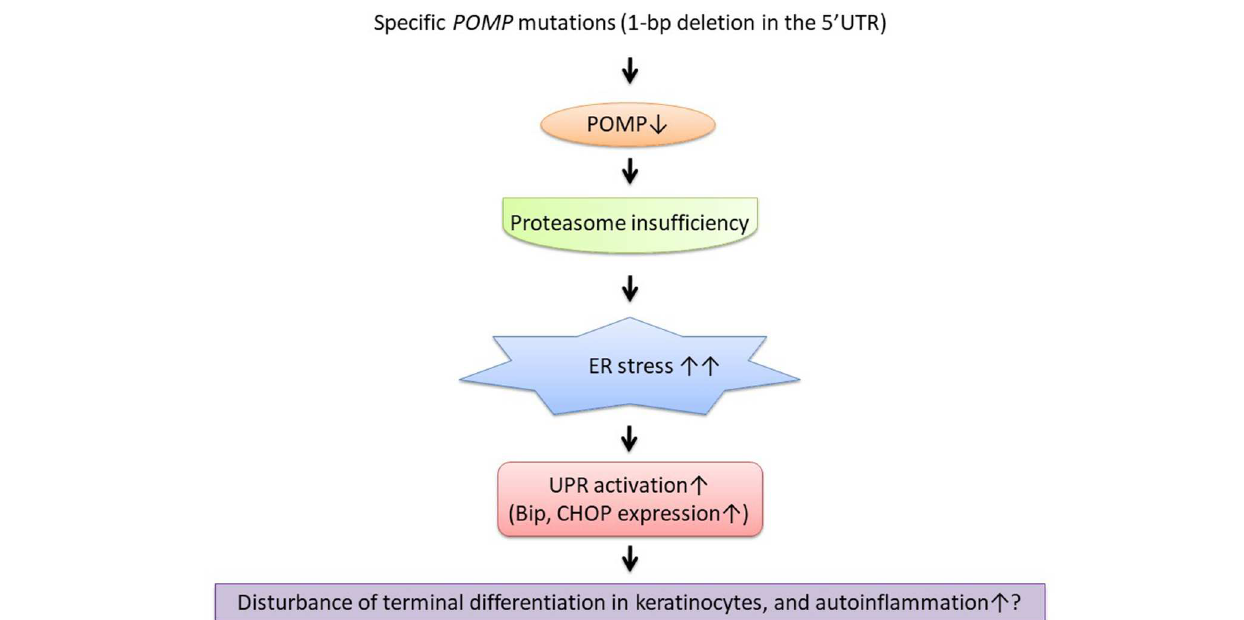
FIGURE 1 | The suggestive pathogenesis of keratosis linearis with ichthyosis congenita and sclerosing keratoderma (KLICK) syndrome as an autoinflammatory keratinization disease (AiKD). ER, endoplasmic reticulum; POMP, proteasome maturation protein; UPR, unfolded protein